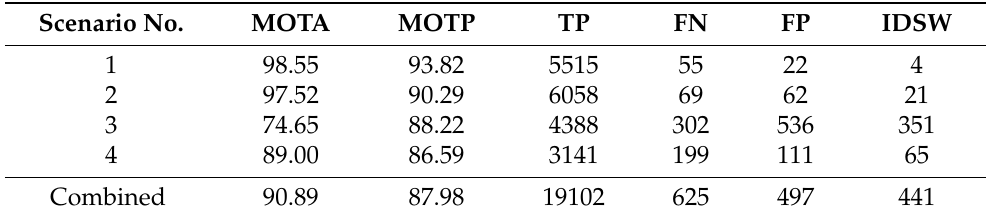
Table 1. Combined results of our tracking methodology evaluated in four scenarios (results repro- duced from our experiments published in our previous work